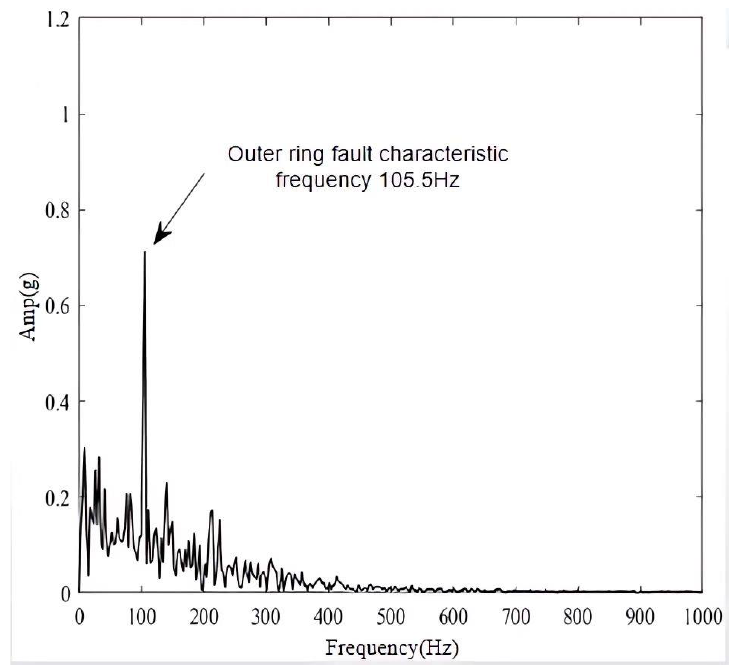
Figure 6. IPSO-VMD Optimum Component Envelope Spectrum.